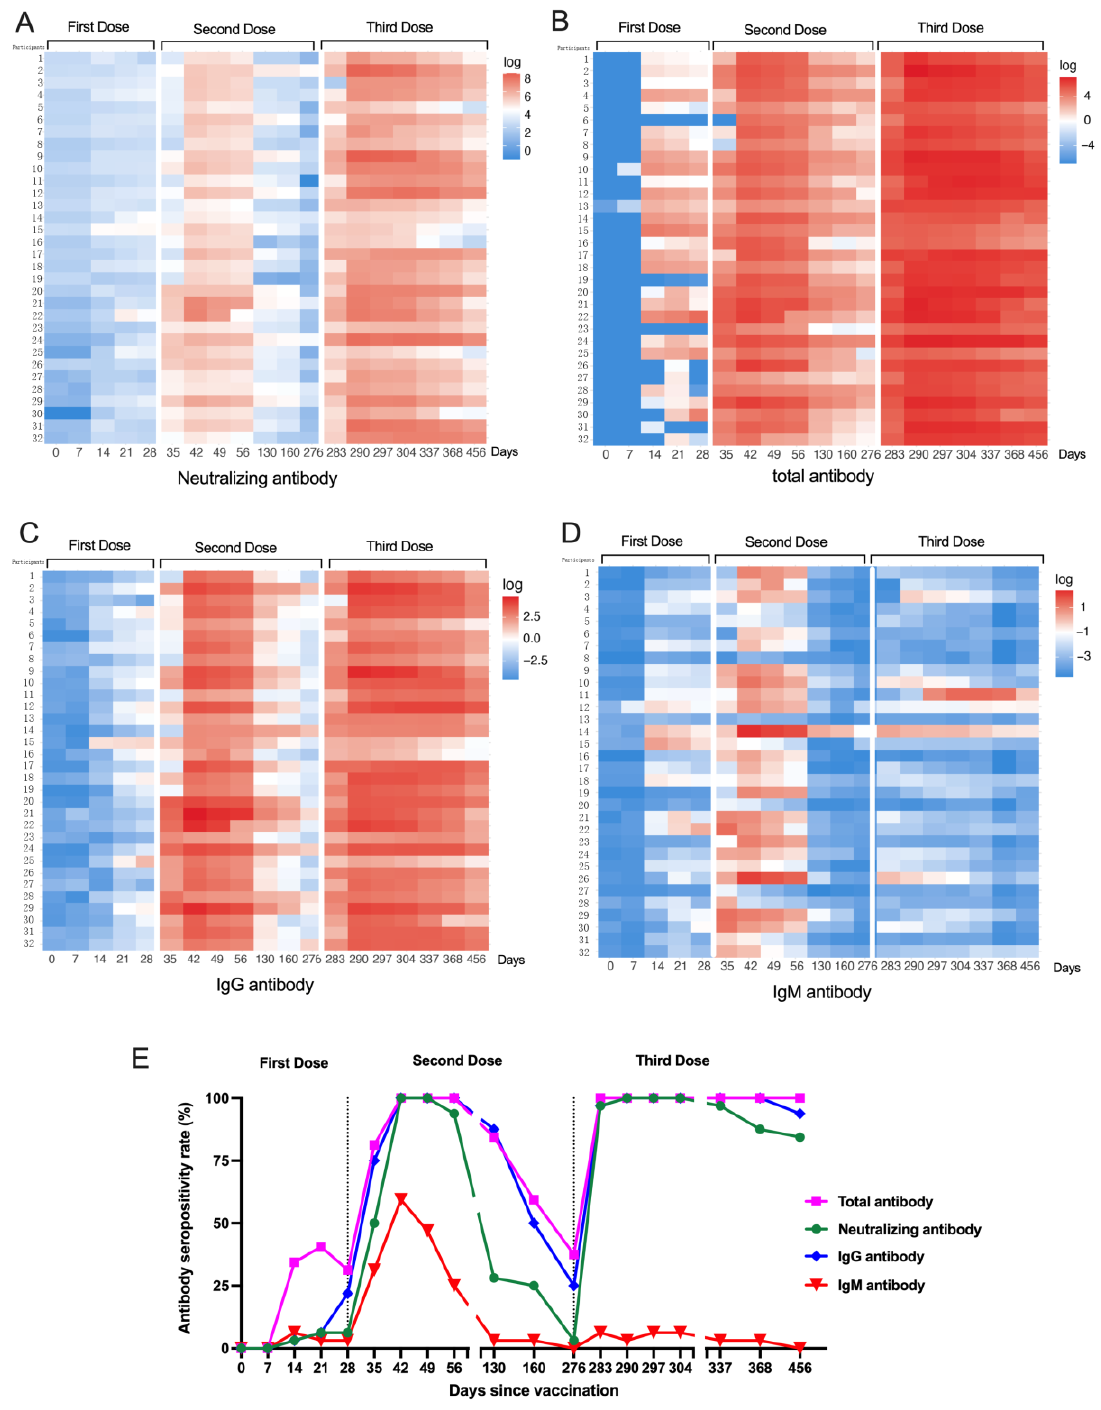
Figure 1. Anti-SARS-CoV-2 antibody response to the vaccines for 32 participants. Heatmaps of the kinetics of anti-SARS-CoV-2 neutralizing antibodies ( A ), anti-SARS-CoV-2 total antibodies ( B ), anti- SARS-CoV-2 IgG antibodies ( C ), and anti-SARS-CoV-2 IgM antibodies ( D ) induced by a three-dose regimen of vaccination. ( E ) Seropositivity rate for the four subsets of anti-SARS-CoV-2 antibodies.